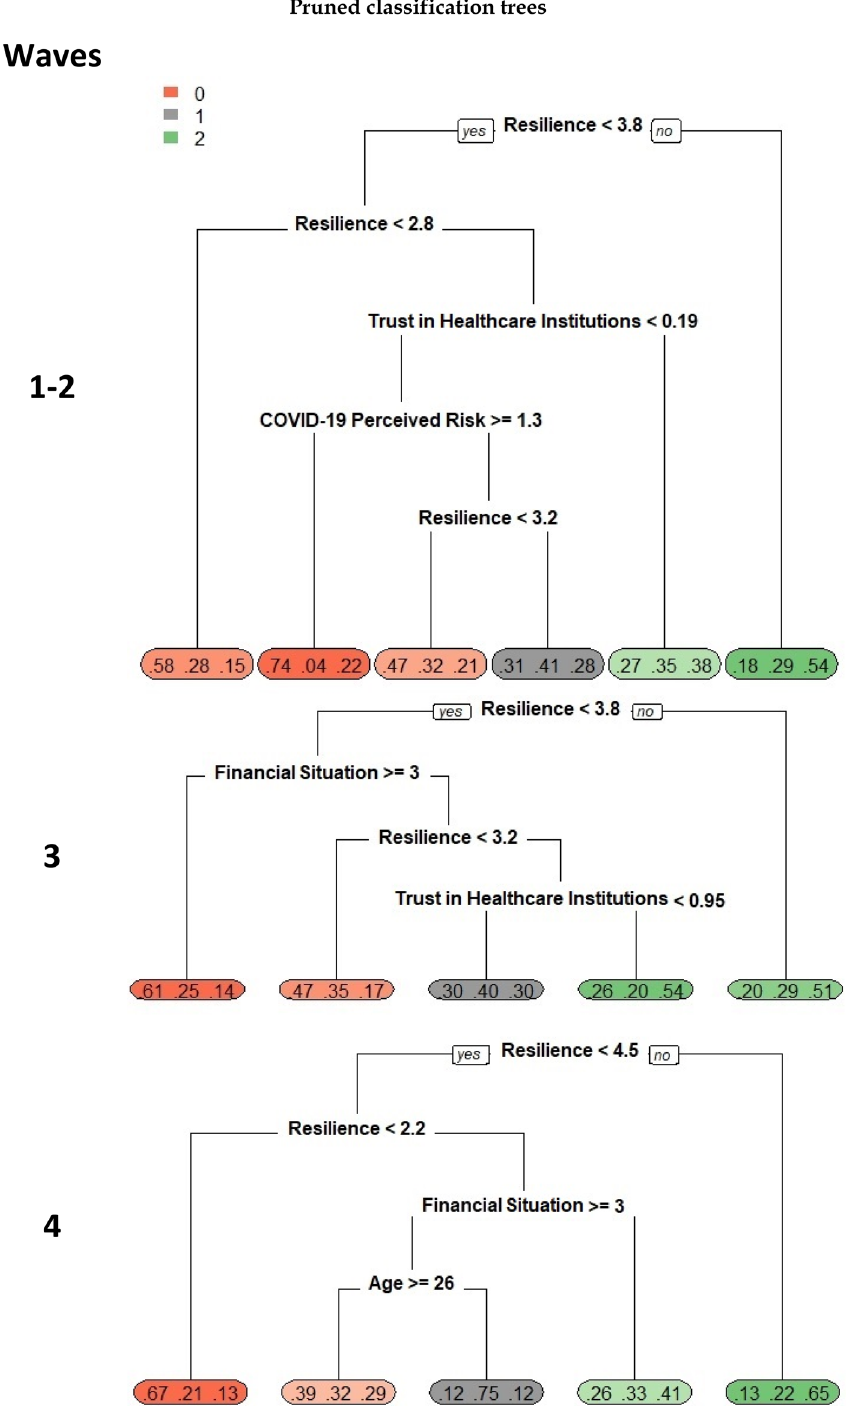
Figure 3. Pruned classification trees. WB status: Well-being status: red 0 = Depression; gray 1 = Poor Well- being; green 2 = Well-being. Resilience range = 1 to 7; COVID-19 Perceived Risk range = -3.3 to 2.5; Trust in Healthcare Institutions range = -2.9 to 1.8; Financial Situation: 1 = Improved, 2 = Remains the same, 3 =